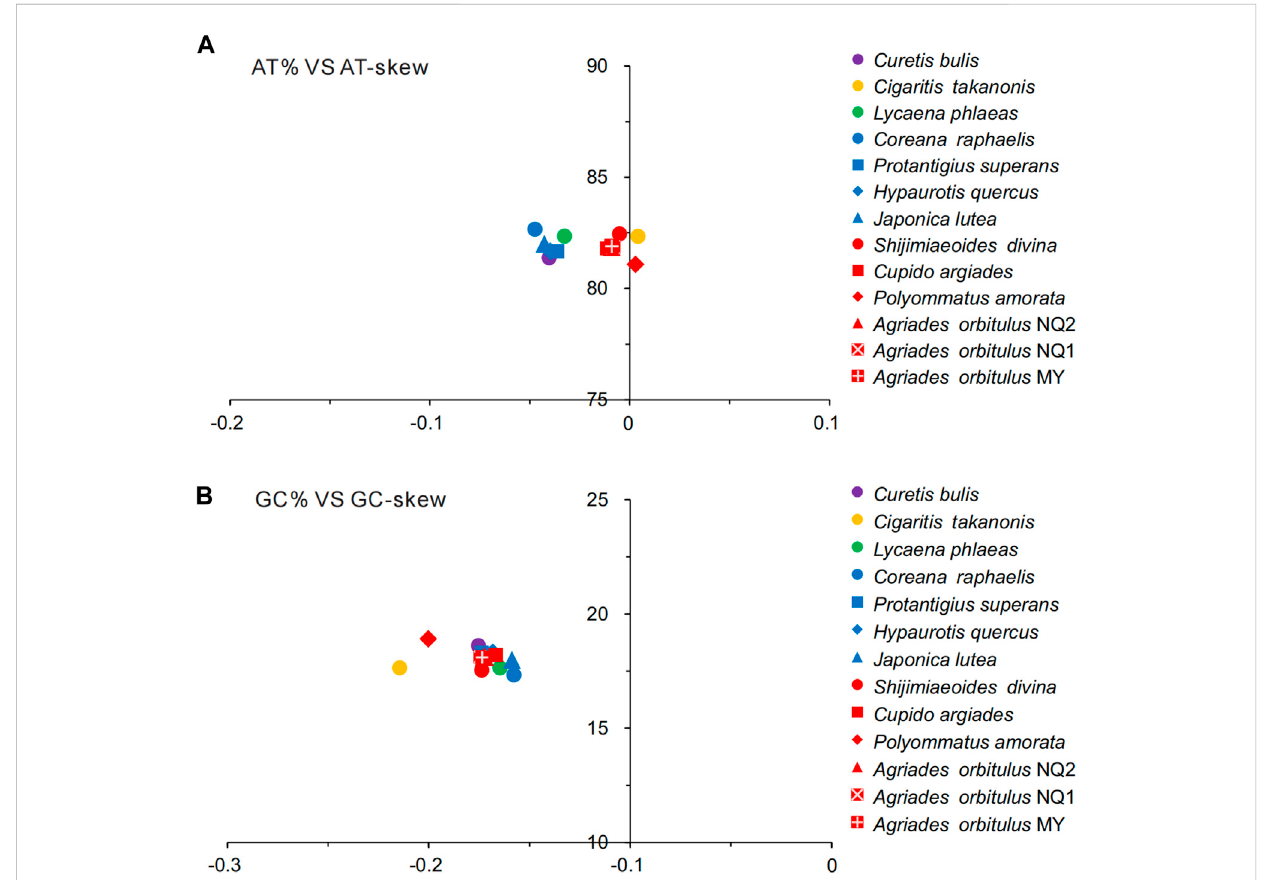
FIGURE 3 AT% vs. AT-skew (A) and GC% vs. GC-skew (B) in the 13 Lycaenidae mitochondrial genomes. Results are shown as the bp percentage ( Y -axis) and nucleotide skews ( X -axis). Values are calculated for J-strands for full-length